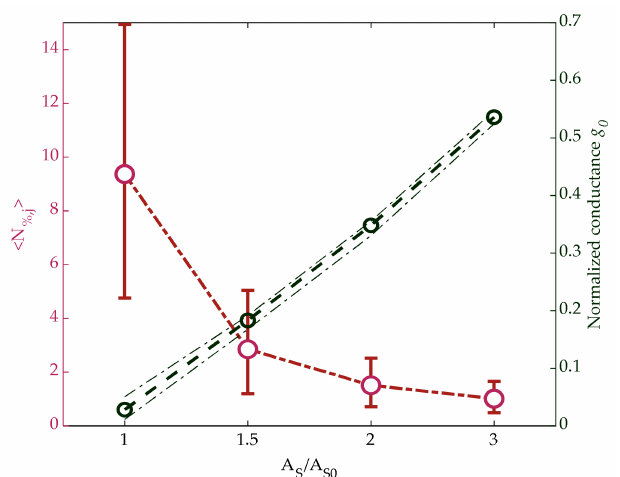
Figure 5. Left : ensemble average over all the tested cells of N %,j defined in (3) vs. SET pulse amplitude. Right : normalized conductance averaged on both time and cells. Error bars and dashed lines represent the 10% and 90% limits of both